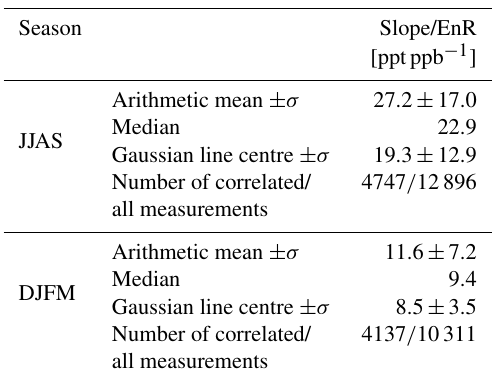
Table 6. Mean and median values of EnR frequency distributions and centre of the fitted Gaussian distributions.